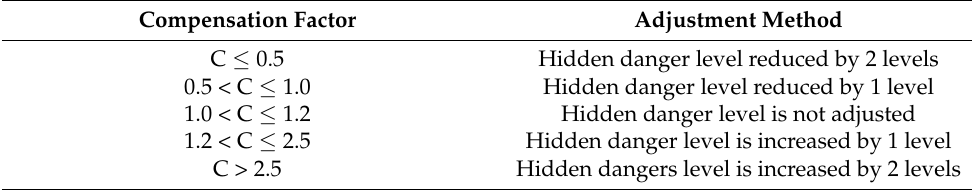
Table 11. Accident potential initial level adjustment method.